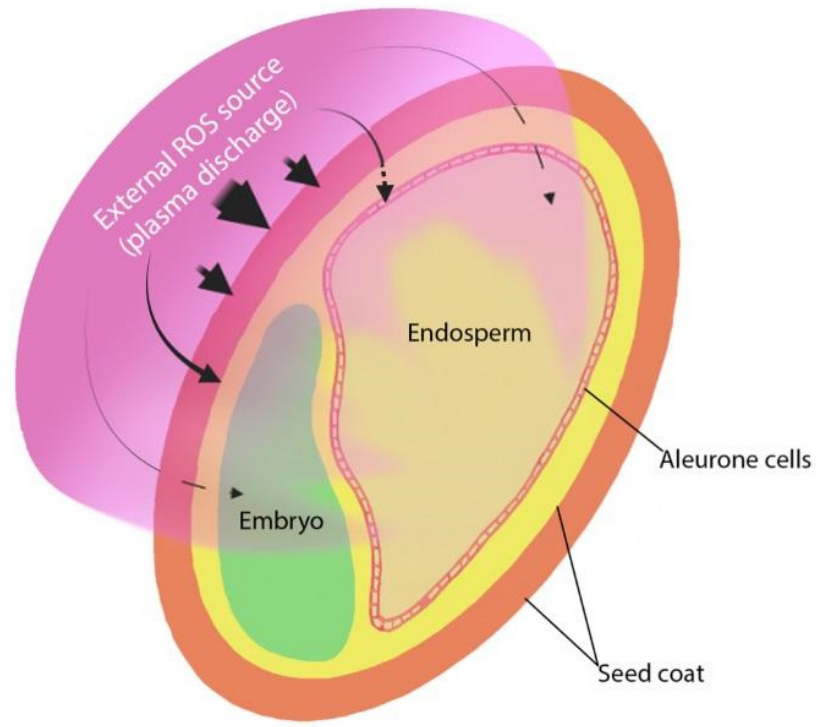
Figure 1. Schematic representation of NTP generated reactive species penetration into structures of the monocot seed.